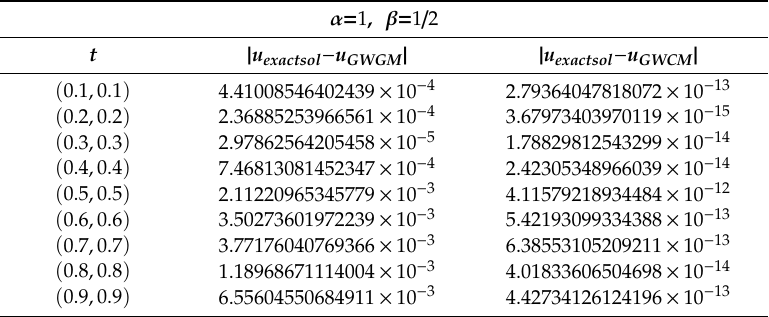
Table 4. Absolute errors of example using the Gegenbauer wavelet collocation method and the Gegenbauer wavelet Galerkin Method at various points of x and t